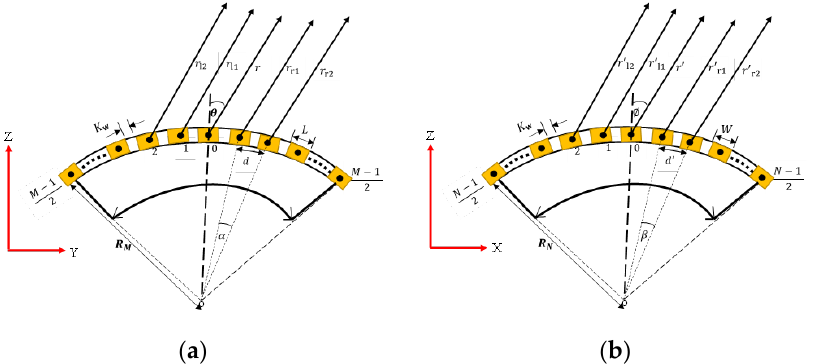
Figure 2. Idealized geometry of the conformal array: ( a ) M-subarray part; ( b ) N-subarray part.